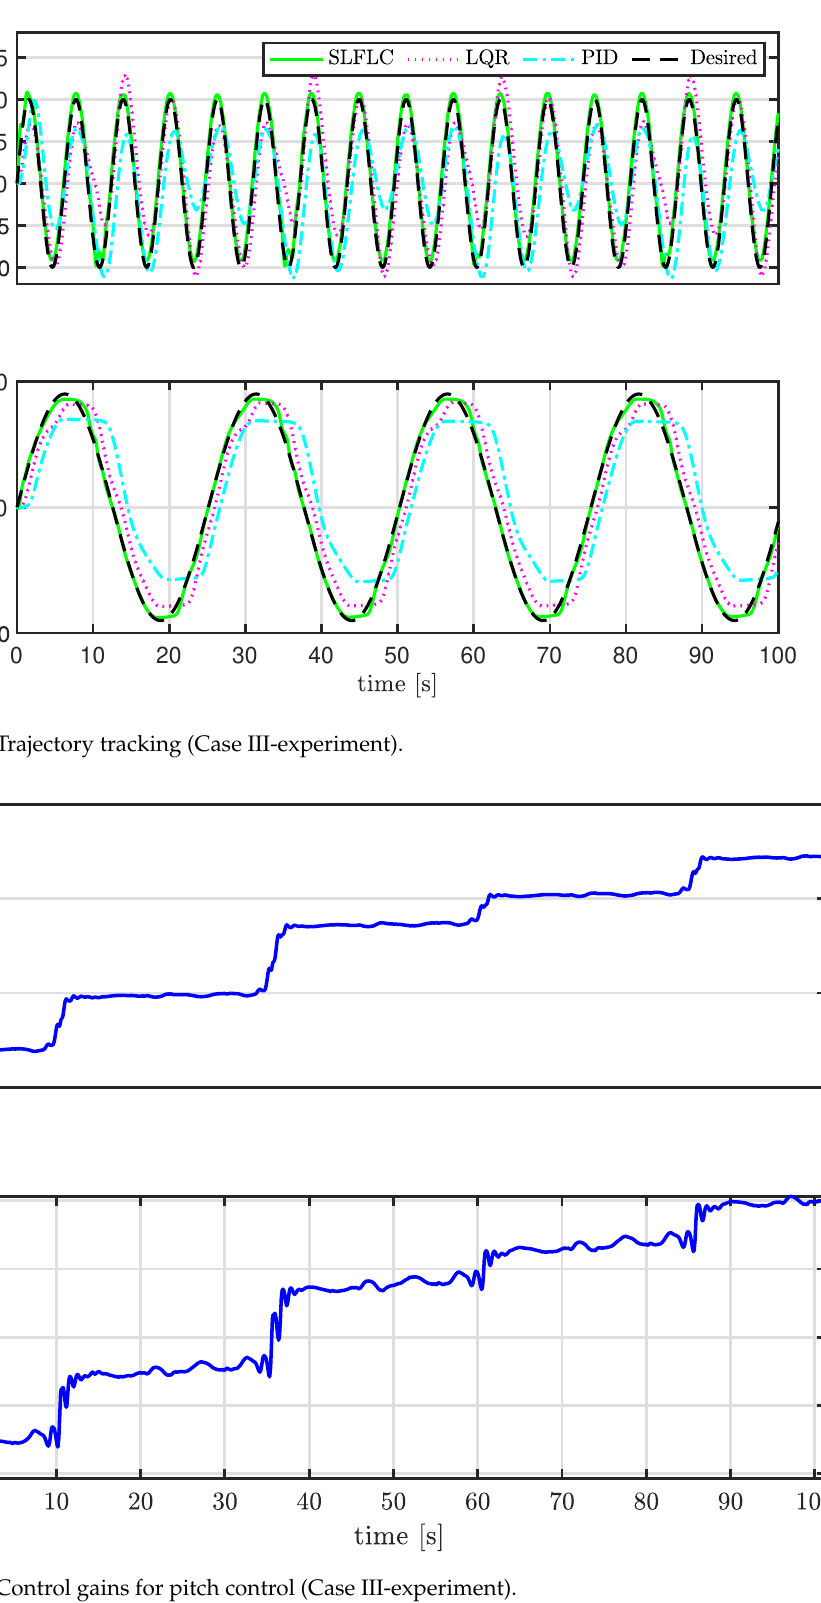
Figure 14. Control gains for pitch control (Case